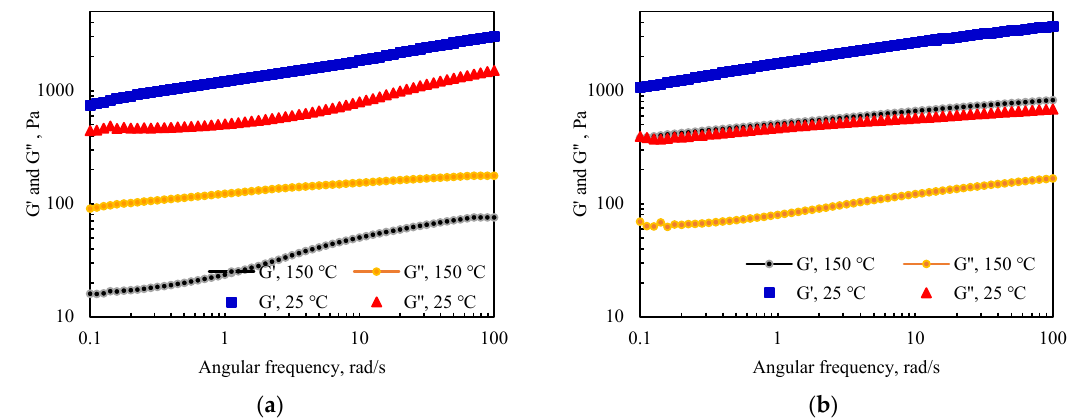
Angular frequency, Figure 8. Comparison of the viscoelastic properties of the PAM-gel and the IPN@sericite-gel at 150 ◦ C and 25 ◦ C: ( a ) PAM-gel; ( b ) IPN@sericite-gel. After high-temperature aging and expansion, the energy storage modulus G’ and energy dissipation modulus G” of the PAM-gel and the IPN@sericite-gel decreased, which occurred due to the breaking of some polymer chains and the destruction of the IPN structures at high temperatures. After the aging of the PAM-gel at 150 ◦ C, a change from G” < G’ to G” > G’ occurred at 25 ◦ C. This indicated that the solid-state characteristics of the PAM-gel changed to those of liquid after high temperature aging, viscosity was prominent, and the cross-linked spatial network structure was destroyed into a polymeric chain structure. The IPN@sericite-gel still showed G’ > G” after aging at 150 ◦ C and still exhibited elasticity of the solid, and the skeletal support of the frozen colloidal was still